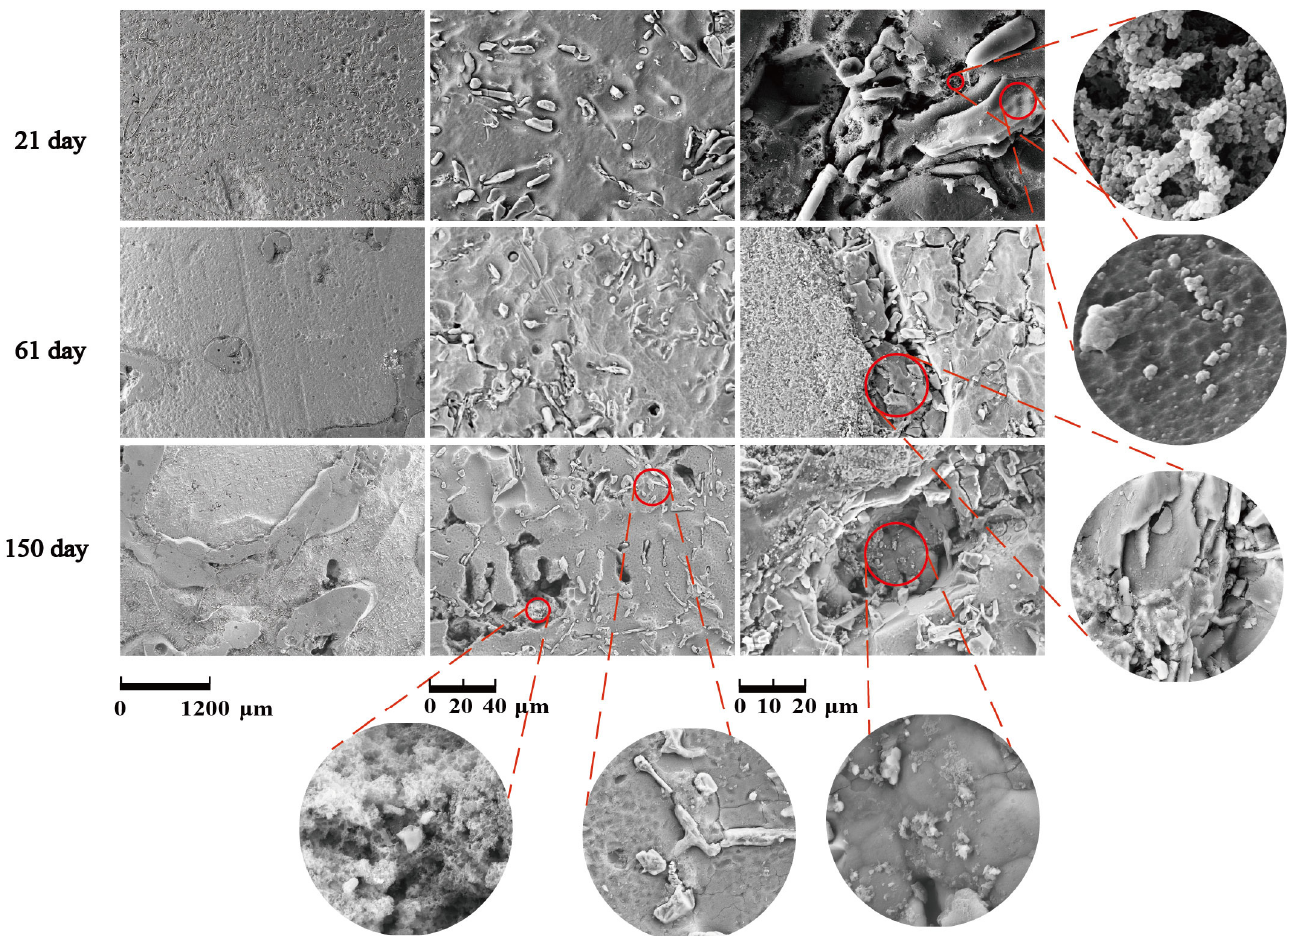
Figure 11. Corrosion morphology of SiC 3D /6061Al for different salt leaching (SL) times.